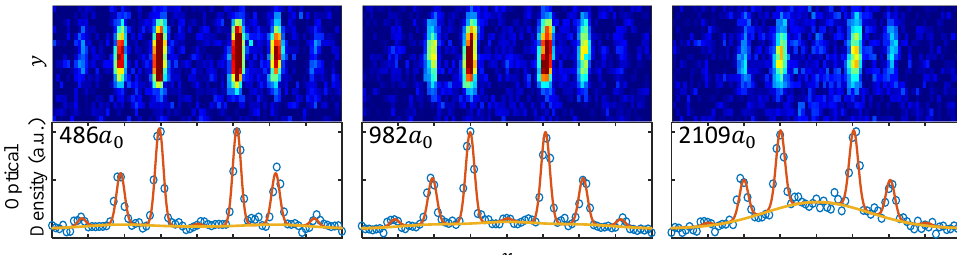
= 500 E and t = 5 µ s at different in- r 0